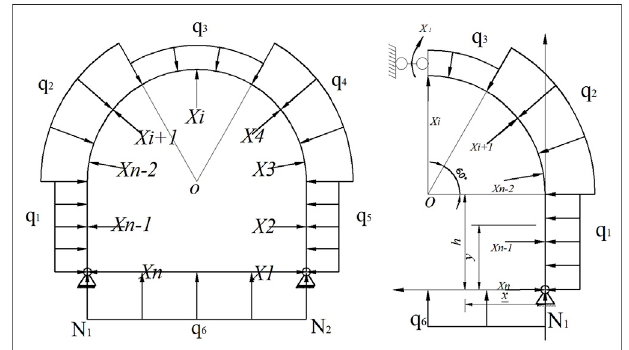
FIGURE 9 | Supporting structure mechanics model of the single